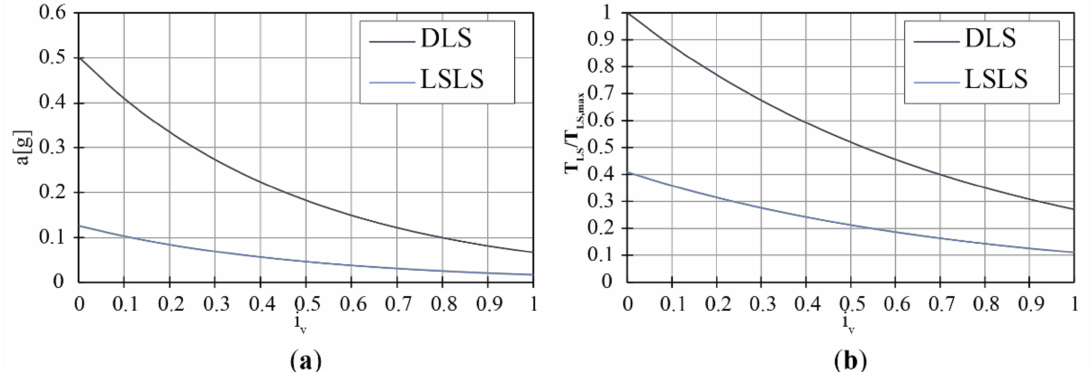
Figure 5. EL1 methodology according to Italian Guidelines related to DLA and LSLS: ( a ) acceleration capacity versus vulnerability index and ( b ) return periods versus vulnerability